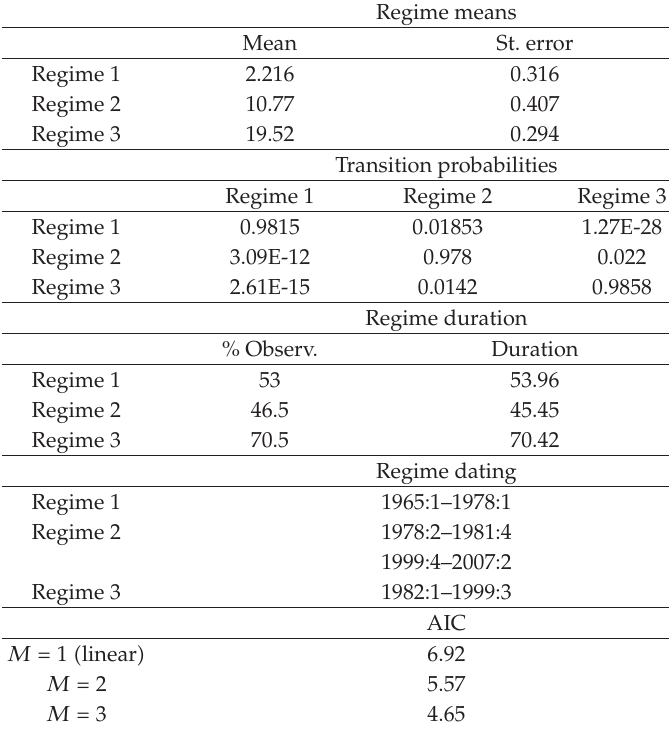
Table 1: Markov-switching model for Spain’s